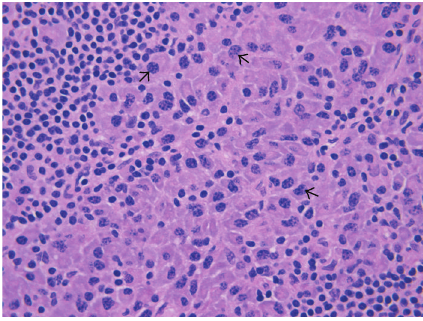
Figure 2: Lymph node with di ff use infiltrate of plasma cells including atypical binucleated and multinucleated forms (black arrows) (H & E stain, x40).